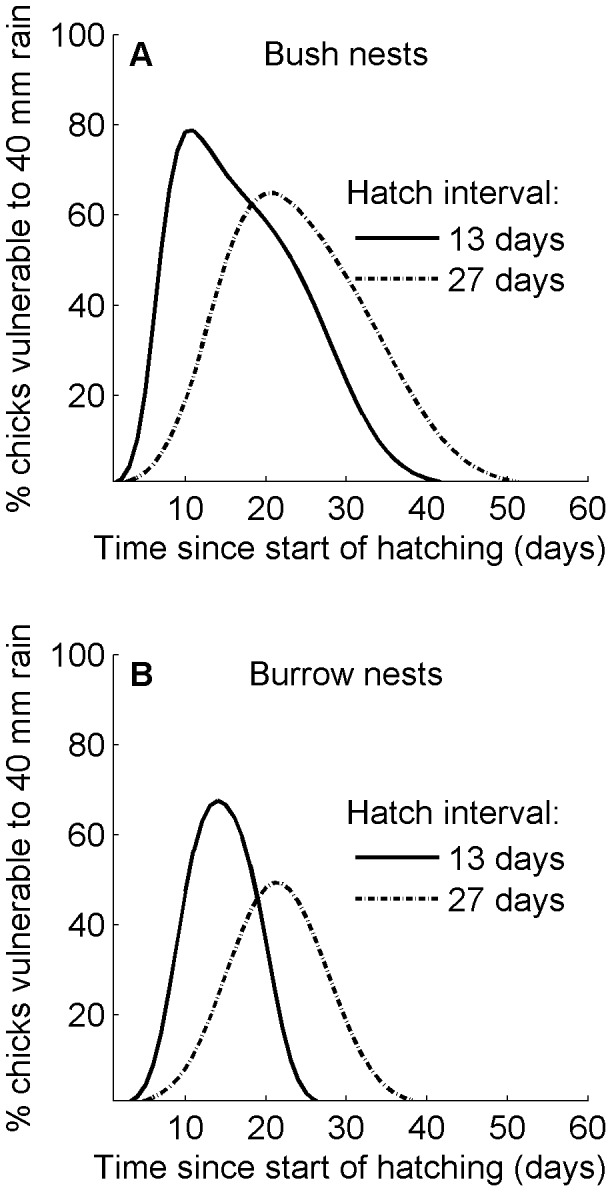
The percentage of Magellanic penguin chicks likely to die in a storm depended on breeding synchrony.The solid lines represent the percentages of chicks likely to die in a storm with 40% of chicks hatched within 13 days. The broken lines represent the percentages of chicks likely to die in the same storm if the hatching interval is 27 days. Both curves assume a normal distribution of hatching dates within the interval and probabilities of dying as shown in Fig. 4 for 40 mm of rain. The curves cross at 19 days. Before that, a storm would kill more chicks if the hatch interval is 13 days; after that, a storm would kill more chicks if the hatch interval is 27 days. (A) Bush nests. (B) Burrow nests.